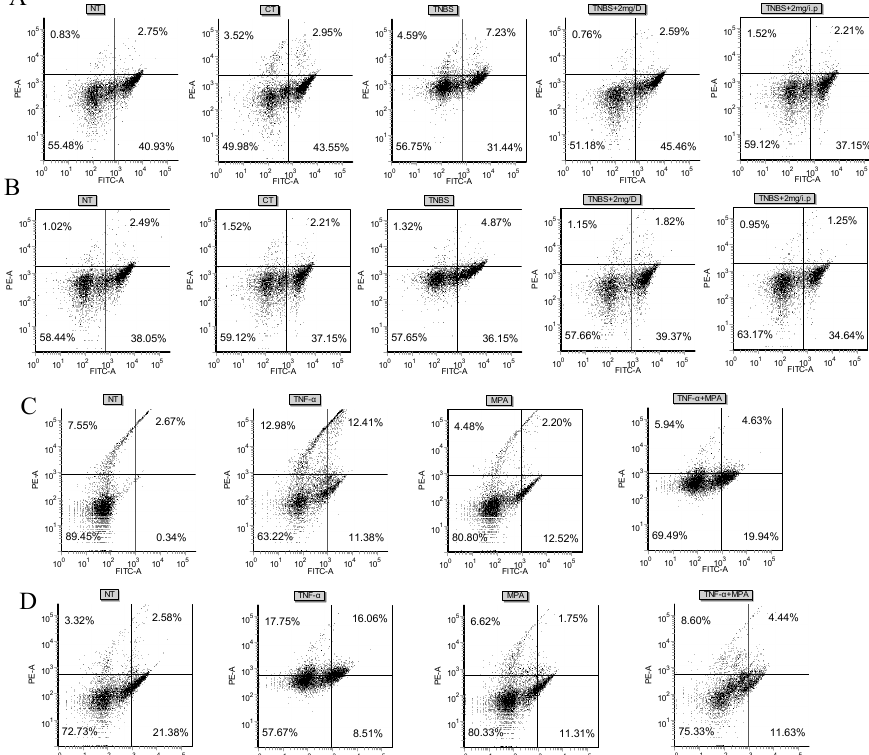
Figure 4. Effects of MMF on the frequency of IFN- γ or IL-4 producing CD4 + T cells in the colons of TNBS-treated mice. Splenocytes were isolated from normal and control TNBS-treated colitic mice and after, treatment with MMF (gavage or i.p., 2 mg) at day three. ( A , B ) The frequencies of CD4 + T cells that produce IFN- γ ( A ) or IL-4 ( B ) in the spleen were determined by flow cytometry after in vitro restimulation with PMA, ionomycin, and Brefeldin-A. Isolated splenocytes in normal mice were pretreated with or without MPA (50 μ M) for 1 h and then stimulated with TNF- α (10 ng/mL) for 14 h. The cells were then stimulated with PMA (20 ng/mL), ionomycin (1 μ g/mL), and Brefeldin-A (1 μ g/mL) for 5 h; ( C , D ) The frequencies of CD4 + T cells that produce IFN- γ ( C ) or IL-4 ( D ) in splenocytes that were treated with MPA in vitro were determined by flow cytometry. D: gavage; PMA: phorbol 12-myristate 13-acetate; MPA: Mycophenolic acid.